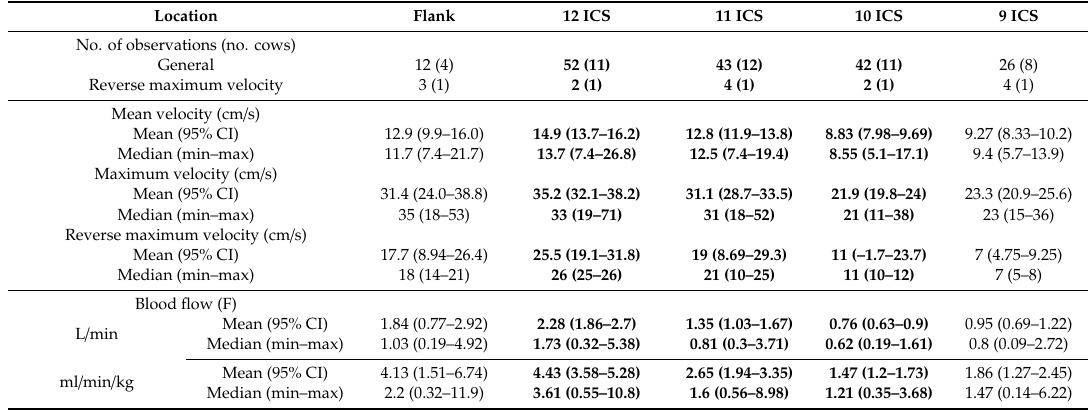
Table 6. Results of ultrasonography examination of the hepatic veins expressed as mean (95% CI) and median (minimum–maximum). Values obtained in the most frequent location are highlighted in bold.